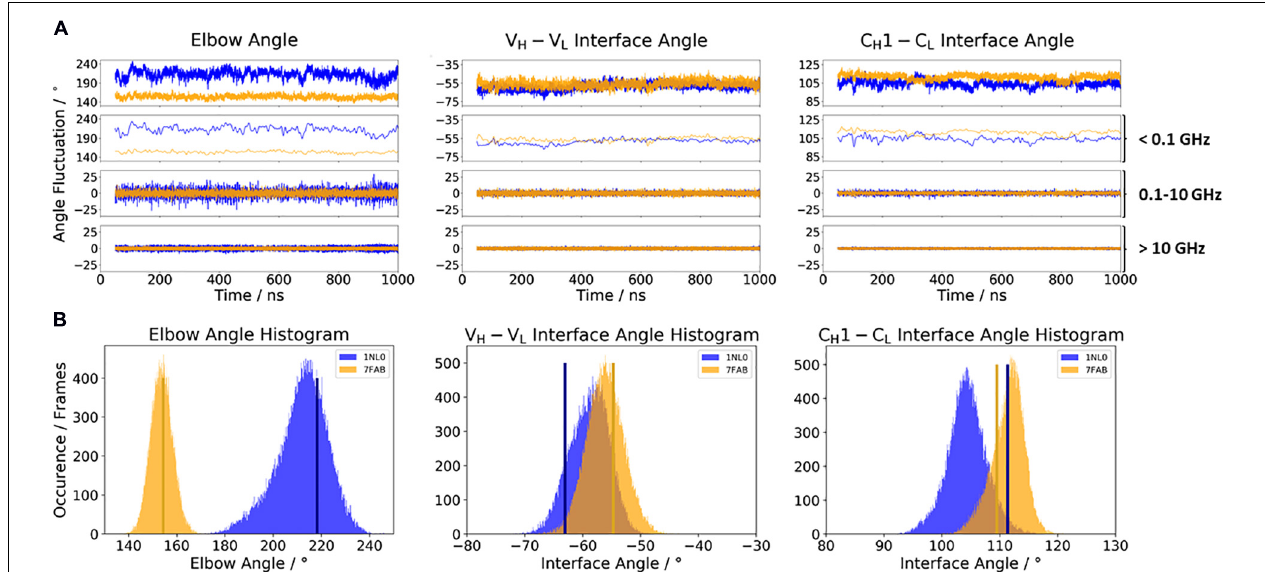
FIGURE 2 | (A) Comparison of the two considered λ light-chain antibodies 10C12 (PDB: 1NL0) and IgG1 Fab (PDB: 7FAB). The biggest difference between these two antibodies is the elbow angle. The distributions of the 10C12 antibody are depicted in blue, while the IgG1 antibody angle distributions are colored yellow. Additionally, the FFT of the respective distributions are displayed, showing the angle variations occurring faster than 1 ns, between 0.1 and 10 ns, and slower than 10 ns. (B) Histograms of the respective interface and elbow angle distributions, including the respective X-ray structures of both λ light chain antibodies, which were used as starting structures for molecular dynamics